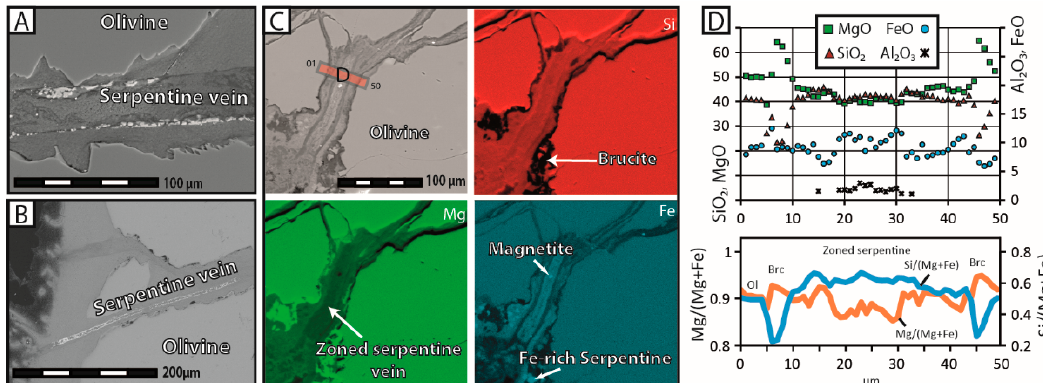
Figure 4. Veins filling pre-existing cracks after reaction in NaOH solution. ( A ) BSE image displaying obvious mineral zoning between the core and rim layers of the vein, the alteration margins made of lizardite and brucite, and the rough profile of the reaction fronts. ( B ) BSE image of a vein outlet containing secondary magnetite. ( C ) EDS elemental maps for Si, Mg and Fe, and ( D ) chemical profiles corresponding to the red band shown in ( C ). Fe and Al are enriched in the core layers due to the high content of serpentine, while the presence of brucite in the alteration rim is testified by prominent Mg peaks. ( A ) is for t = 6 months (run # 2), and ( B – D ) are for t = 12 months (run # 3).